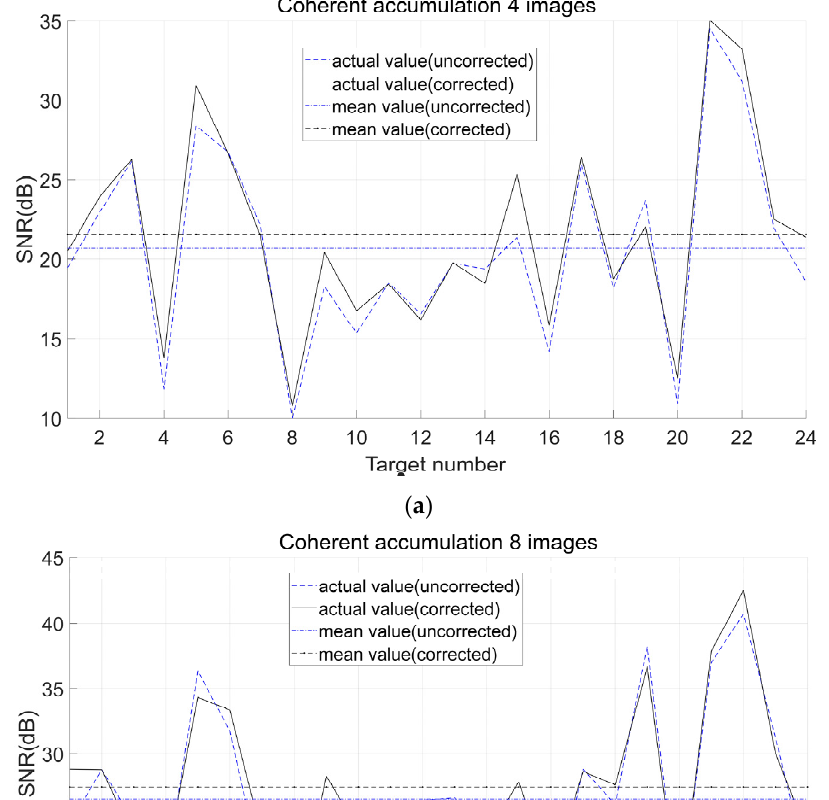
Figure 15. The comparison of coherent accumulation images: ( a ) using 4 images (uncorrected); ( b ) using 4 images (corrected). ( c ) using 8 images (uncorrected); ( d ) using 8 images (corrected). ( e ) using 16 images (uncorrected); ( f ) using 16 images (corrected).